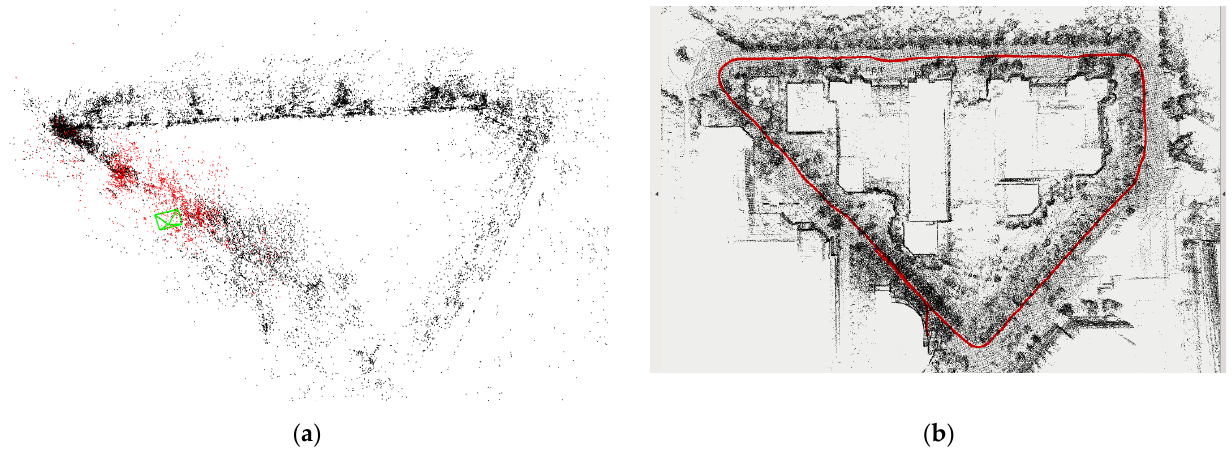
Figure 10. Mapping effect of ORB-SLAM2 algorithm and LV-SLAM algorithm. ( a ) The map output by the ORB-SLAM2 algorithm; ( b ) the map output by the LV-SLAM algorithm.